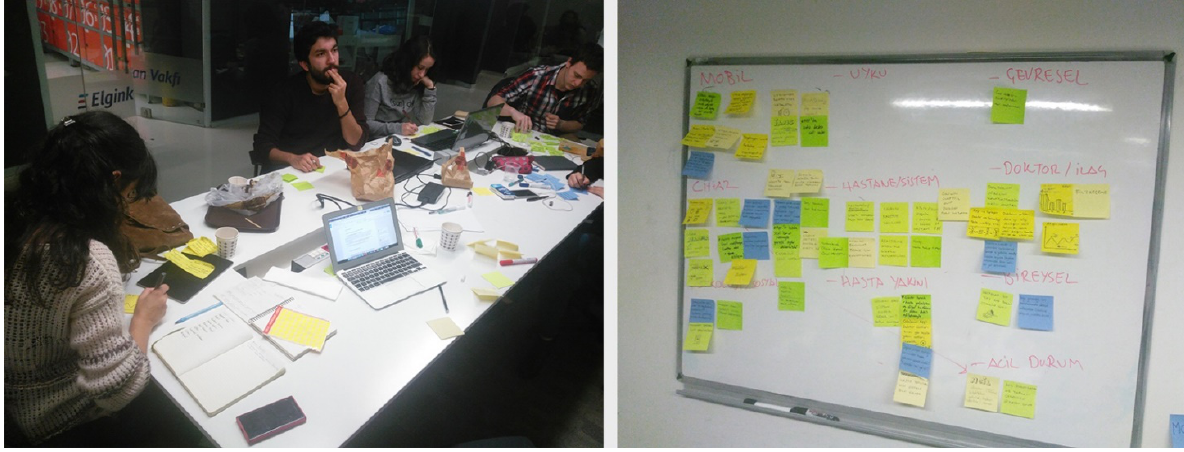
Figure 9: Workshop session for